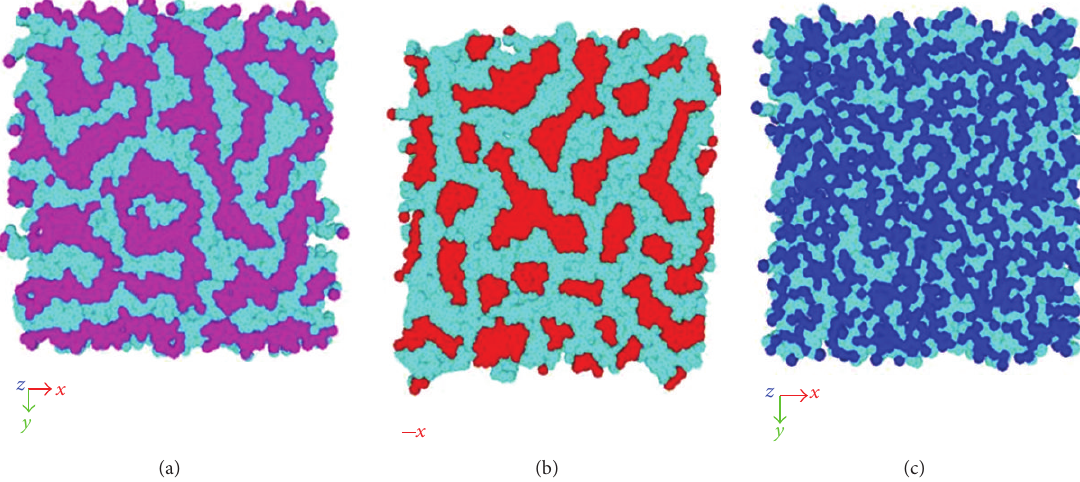
Figure26:Bottomviewsnapshotsof(a)Z-dol(pink:end-group),(b)Z-tetraol(red:end-group),and(c)DDPA(blue:end-group)ondiamond overcoat surface (light blue: backbone).